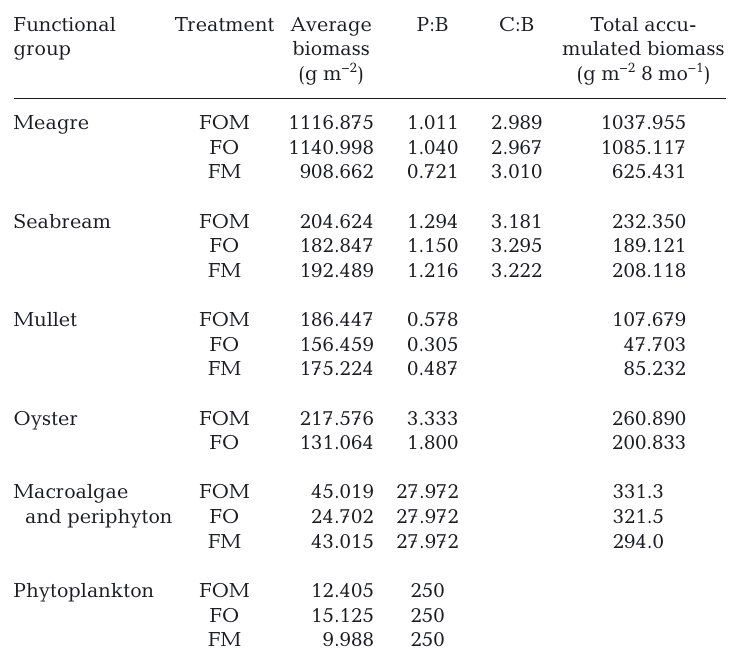
Table 4. Input parameters for the functional groups, based on experimental data from each treatment. P:B: production:biomass ratio; C:B: consumption:bio- mass ratio; FOM: fish, oysters and macroalgae; FO: fish and oysters; FM: fish and